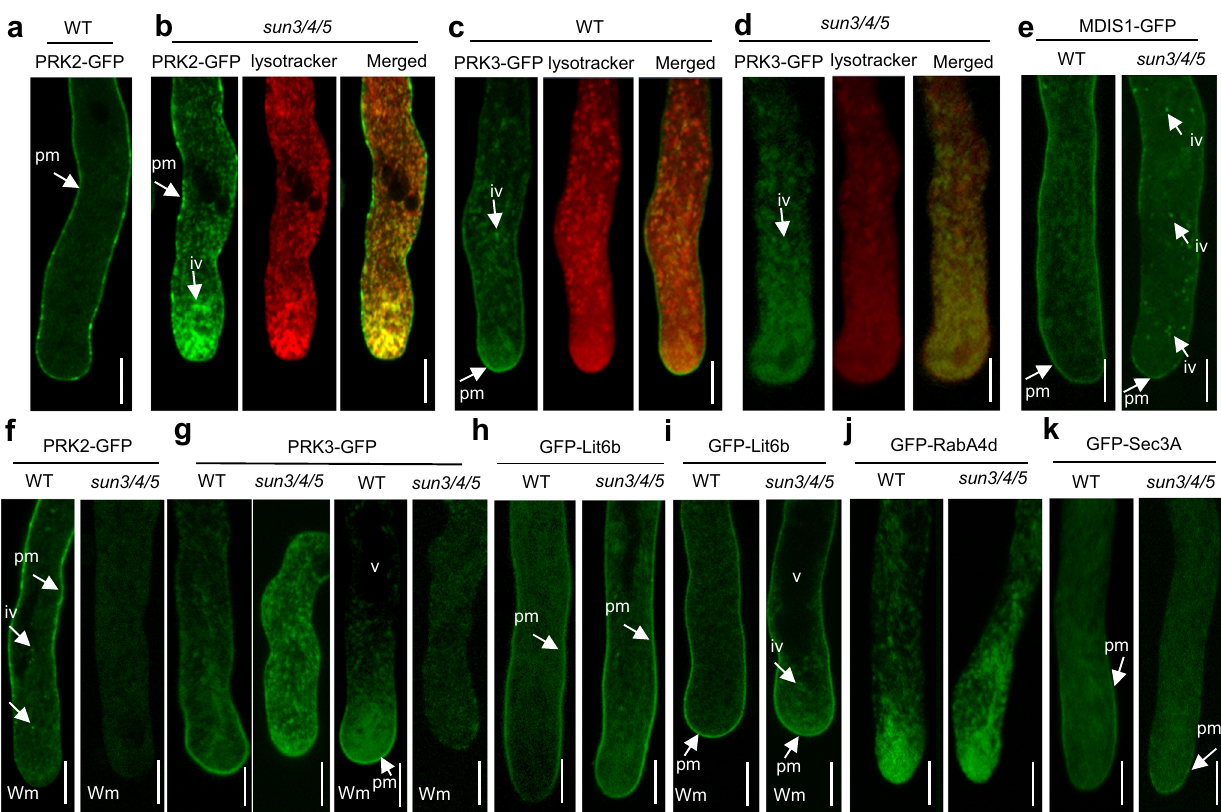
Fig. 5 Localization of cargoes in sun3/4/5 pollen tubes. a Plasma membrane (pm) localization of PRK2-GFP in the WT. b PRK2-GFP enriched intracellular vesicles (iv) were stained with LysoTracker red in sun3/4/5 . c PRK3-GFP is localized on the PM and intracellular vesicles in the WT. d The PM localization of PRK3 is impaired in sun3/4/5 , and mainly localized in acidic vesicles stained by LysoTracker red. e The PM localization of MDIS1 was partially impaired in sun3/4/5 . f Wortmannin (Wm) treatment disrupts the PM localization of PRK2-GFP at the apex and subapex region of WT pollen tubes. PRK2-GFP signal disappeared after Wm treatment in sun3/4/5 . g In sun3/4/5 , PRK3-GFP signal disappeared after Wm treatment, but in WT, the signal on the PM and vesicles remained. h The PM localization of GFP-Lit6b in sun3/4/5 . i The PM localization of GFP-Lit6b after Wm treatment in sun3/4/ 5 . j The vesicle localization of RabA4d at the apex region is not affected in sun3/4/5 . k The PM localization of GFP-Sec3A is not affected in sun3/4/5 . 3 ( a - k ) independent biological experiments were repeated. Bar, 5 μ m. v,